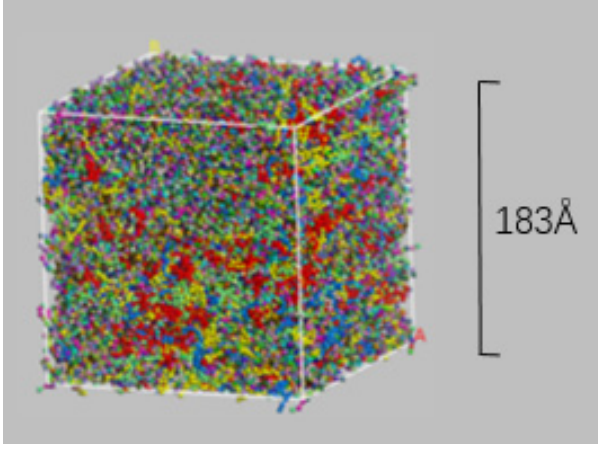
Figure 3. Coarse-grained molecular model of bitumen.